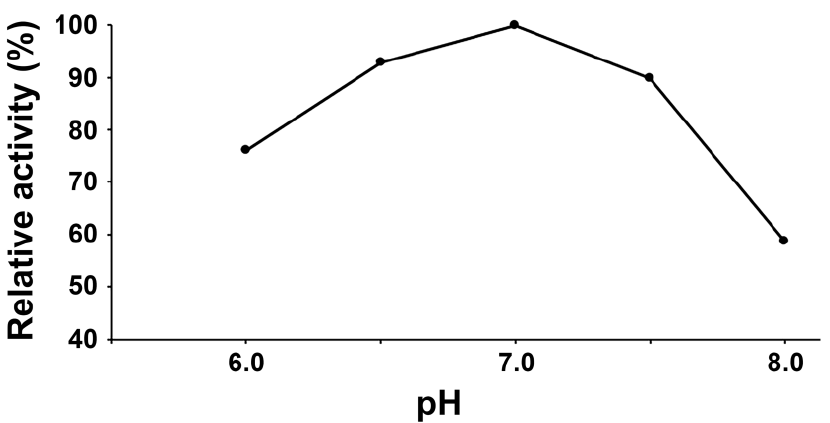
Figure 4. The dependence of the recombinant CYP74C44 catalytic activity on the pH value of the reaction mixture.